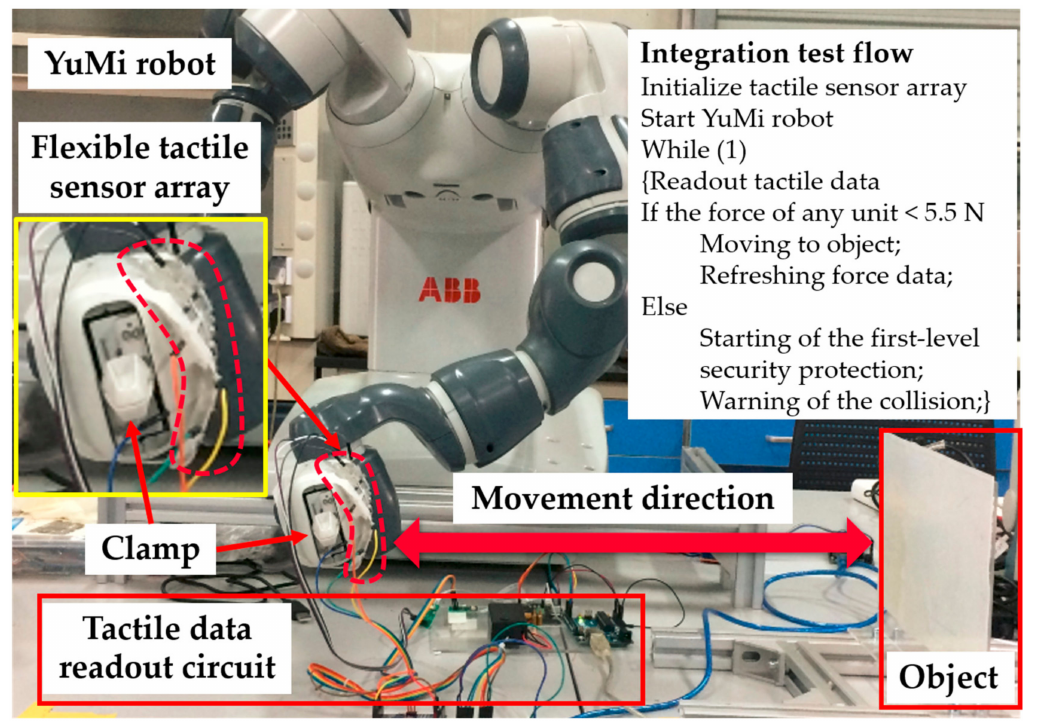
Figure 10. The configuration of the security test based on a YuMi robot integrated with the developed 3D flexible tactile sensor